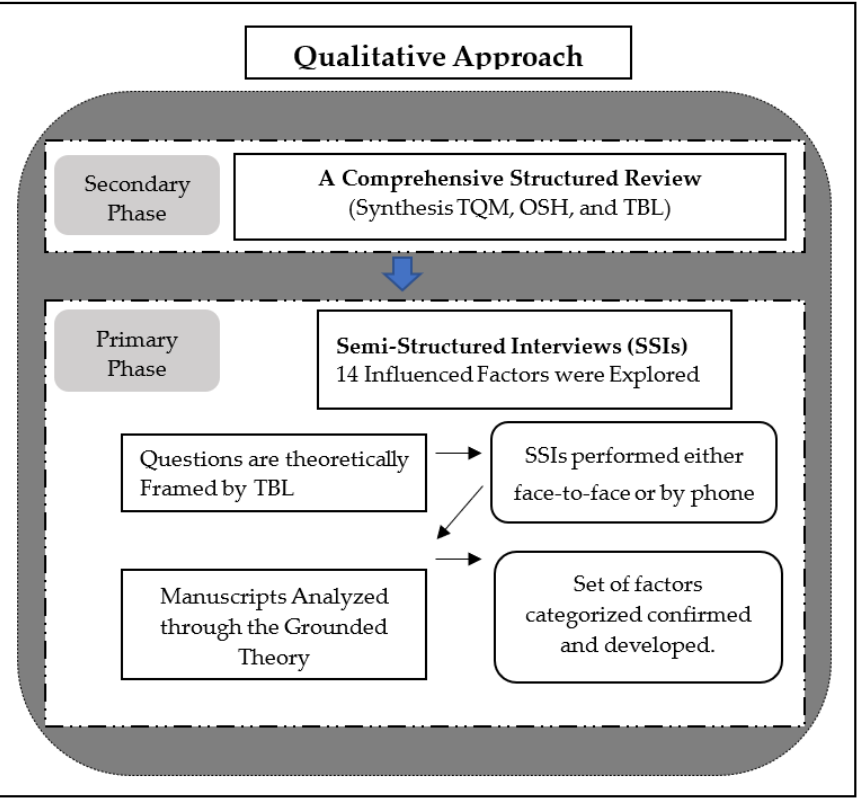
Figure 1. Research design (source: own study).